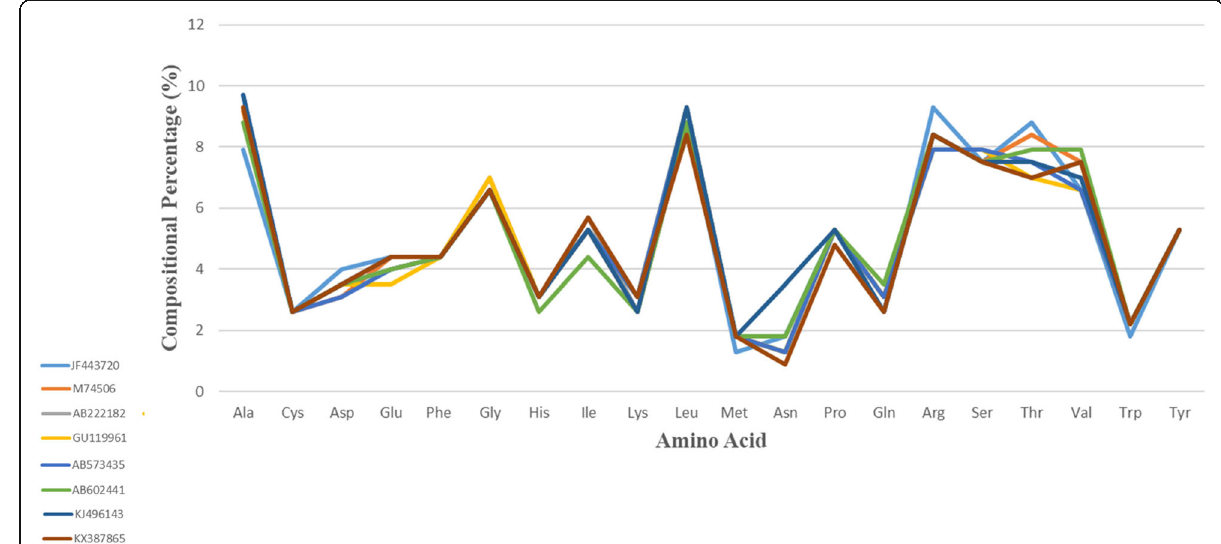
Fig. 2 Depiction of amino acid percentage composition in the YDR sequences considered for the study: (A) JF443720 (GT 1), (B) M74506 (GT 2), (C) AB222182 (GT 3), (D) GU119961 (GT 4), (E) AB573435 (GT 5), (F) AB602441 (GT 6), KJ496143 (GT 7), and (H) KX387865 (GT